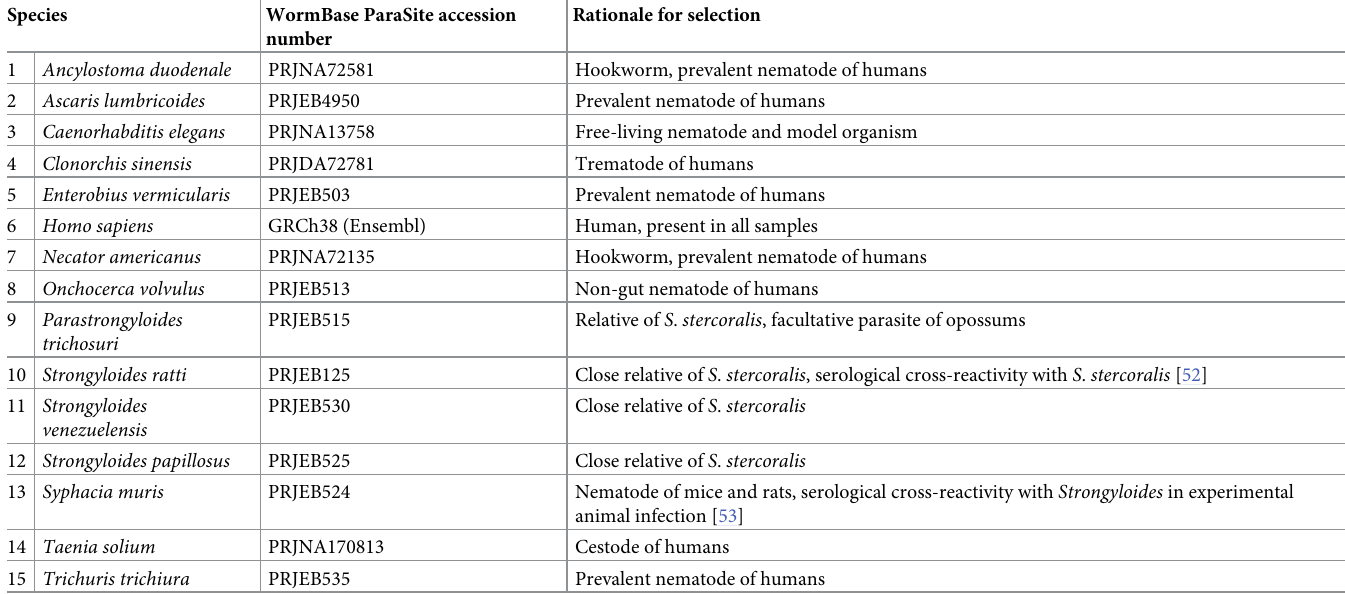
Table 2. Outgroup species used for phylogenetic comparison to S . stercoralis